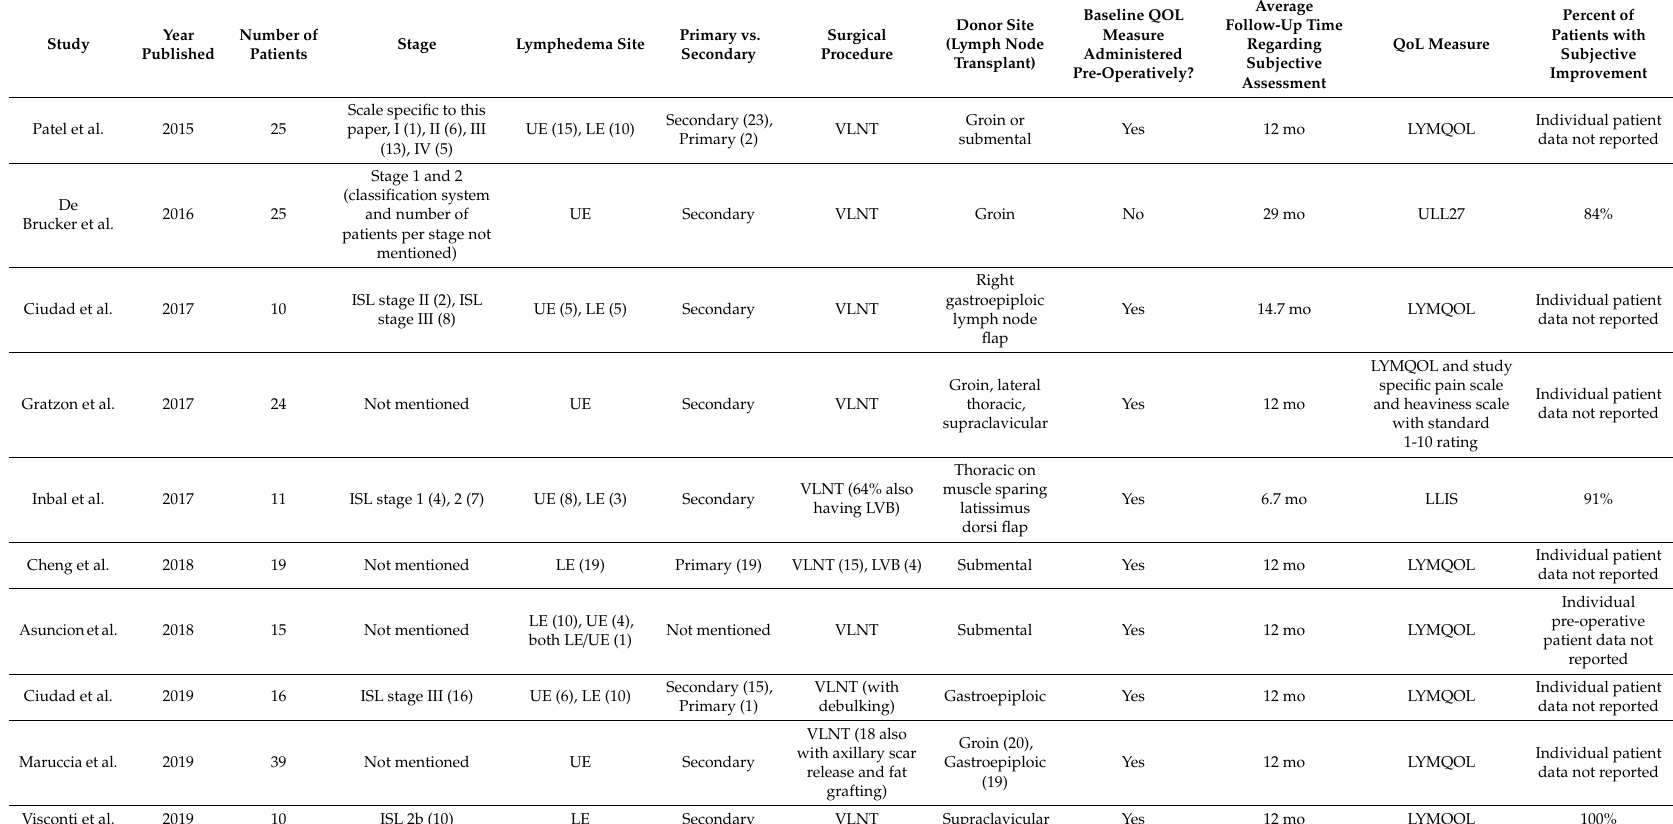
Table 5. QOL in VLNT using validated